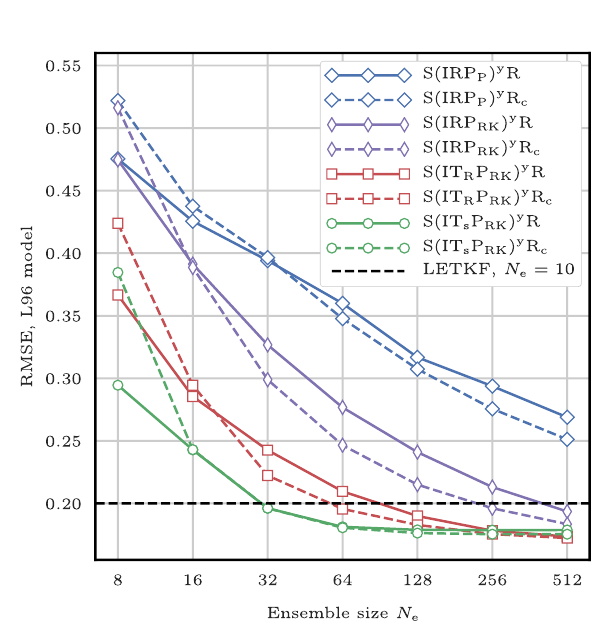
Figure 20. RMSE as a function of the ensemble size N e for the LPF y